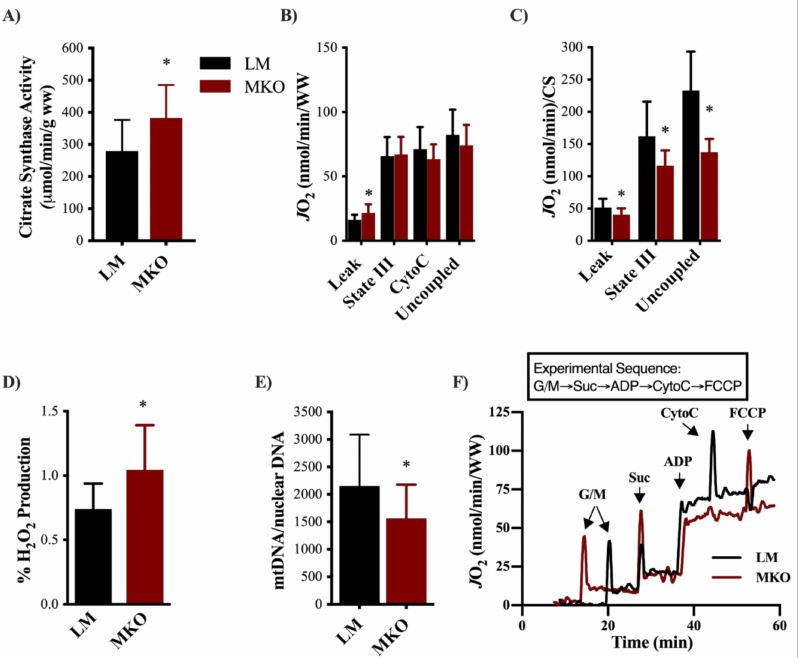
Figure 5. Lifelong Ulk1 deficiency results in an accumulation of dysfunctional